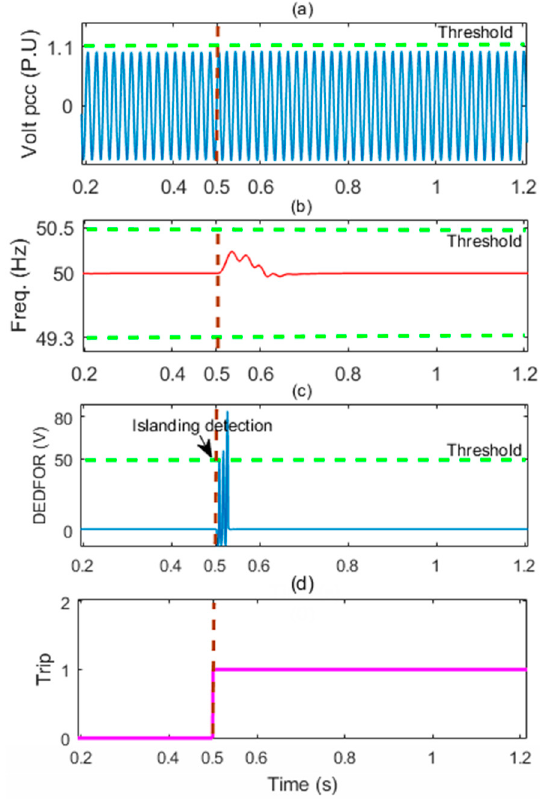
Figure 6. Case 1: ( a ) voltage at PCC; ( b ) frequency at PCC; ( c ) output of the proposed DEDFOR; ( d ) the trip signal for CB1.